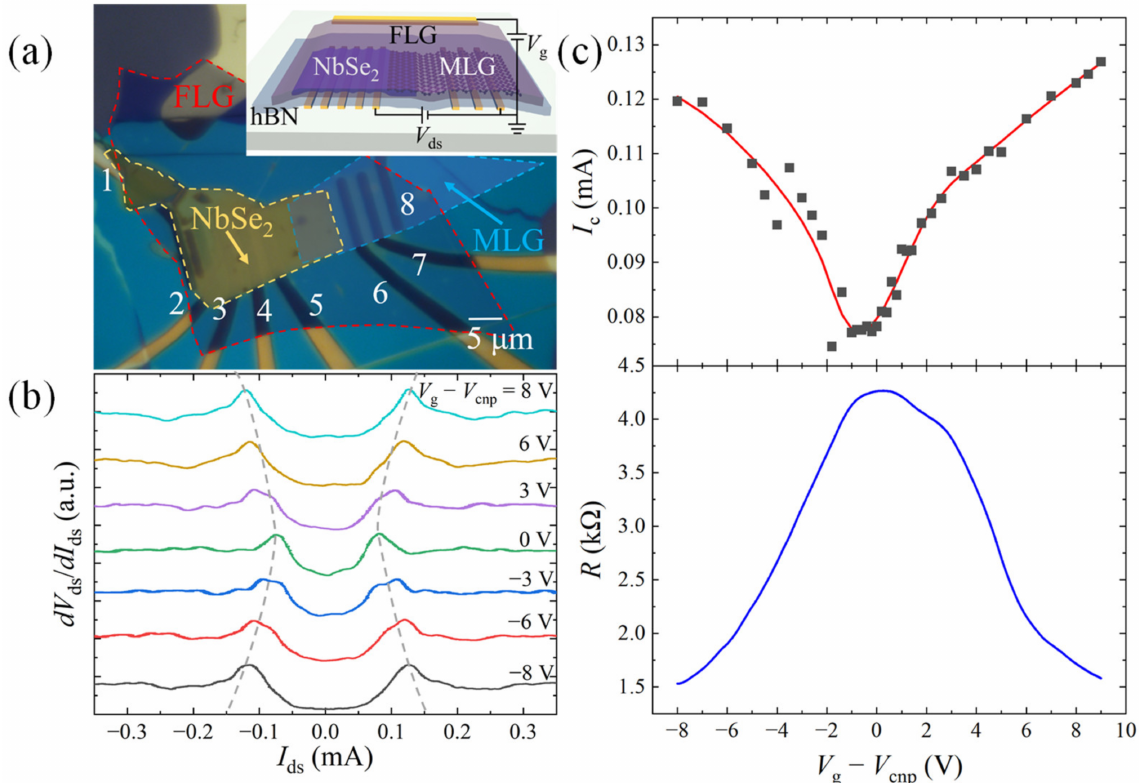
Figure 1. Device structure and the electrical transport characterization of a NbSe 2 -graphene hetero- junction. ( a ) Optical microscope image of a multi-terminal device with false coloring for clarity. The edge of the NbSe 2 , MLG, and FLG nano-flakes is marked by the yellow, blue, and red dashed line, respectively. The metal electrodes are numbered from 1 to 8. Inset: Schematic of the NbSe 2 -graphene heterojunction device. ( b ) Differential resistance dV ds / dI ds as a function of the bias current I ds at selected top gate voltages V g − V cnp . The dc bias current flows from electrodes 3 to 8, while the voltage is measured between electrodes 4 and 5. ( c ) Top: The critical current I c as a function of the top gate voltage V g − V cnp (black square dots) extracted from ( b ). The red solid line is added as a guide to the eye. Bottom: Gate-dependent two-probe (electrodes 6 and 8) resistance of the